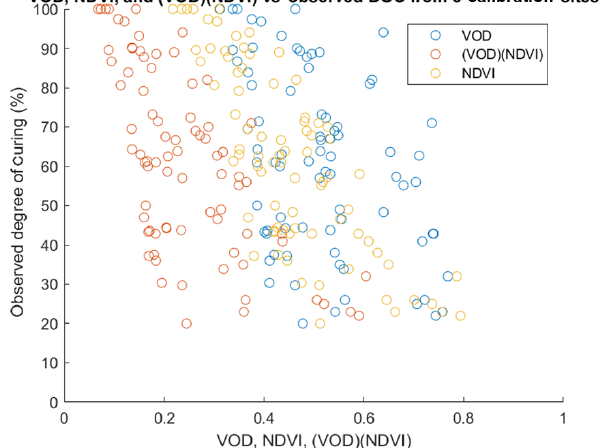
Figure 3. Scatter plot of observed degree of curing (DOC) from five calibration sites against VOD, NDVI, and combined VOD and NDVI terms.